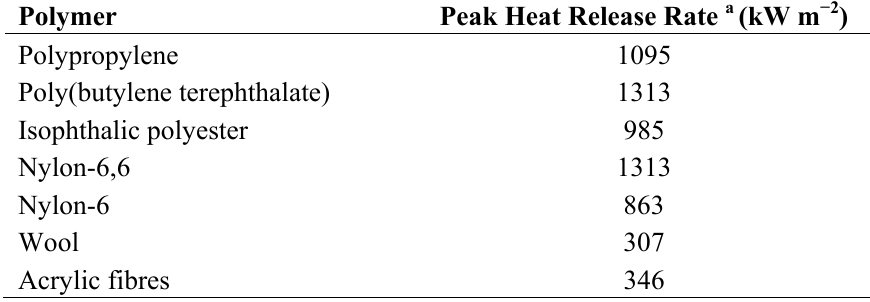
Table 2. Some representative peak heat release rates obtained by cone